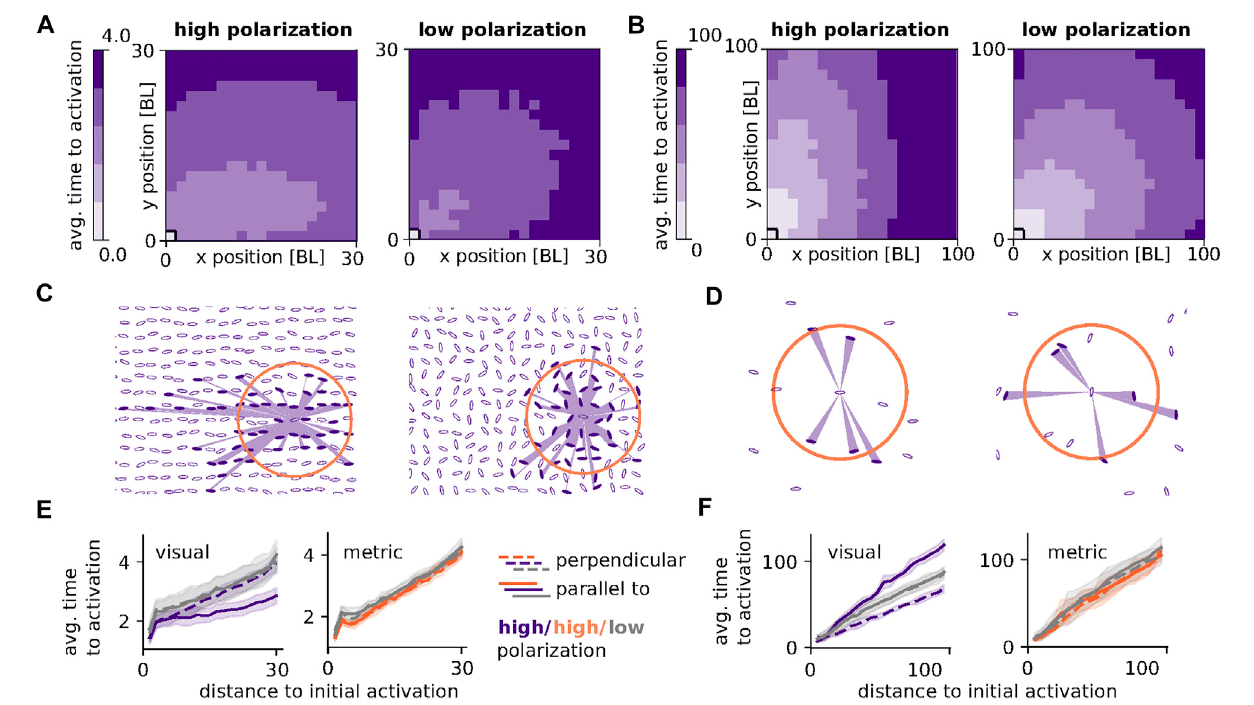
FIGURE 6 | Anisotropic spreading of simple contagion for high group polarization: (A) Propagation time of a simple contagion process initiated at t (cid:1) 0 by one individualinthebottomleftcornerofa20 × 20gridwith g (cid:1) 1.5BLandhigh( left , Φ ∈ [0.8,1.0])andlow( right , Φ ∈ [0.0,0.2])polarizationalongthe x -axis.Averagetimeto activation(time, t > 0,atwhichanindividualatposition(x,y)isinfected)isobtainedasanaverageover30visualnetworkswith50runseachand θ visual (cid:1) 0.01. (B) Like(A), but for g (cid:1) 5.0and θ visual (cid:1) 0.1. (C) and (D) Illustrations ofthe spatial con fi gurations and visual fi elds used inthecontruction ofnetworksunderlying the resultsof(A) and (B) respectively. Visual angles α ij > θ visual are shown as shaded purple areas for one exemplary focal individual. Orange circles indicate the metric thresholds used in the construction of (E), θ metric (cid:1) 6, and (F) θ metric (cid:1) 7. (E) Average time to activation averaged over 3 outer rows in x (solid lines) and y (dashed lines) direction for high (purple,orange)andlow(grey)polarization.Thecontagionspreadsfasterparallelthanperpendiculartothepolarizationforthevisualnetworks (left) .Formetricnetworks (right) polarization has no effect on activation time. Parameters as in (A) and (C). (F) As in (E) but with parameters as in (B) and (D). For this combination of density and visualthresholdthecontagionspreadsfasterperpendiculartothepolarization.Metricthresholdswerechosentoyieldsimilarcontagionspeedsaslowpolarizationvisual networks. Parameters: N (cid:1) 400, γ (cid:1) 0.03, β (cid:1)